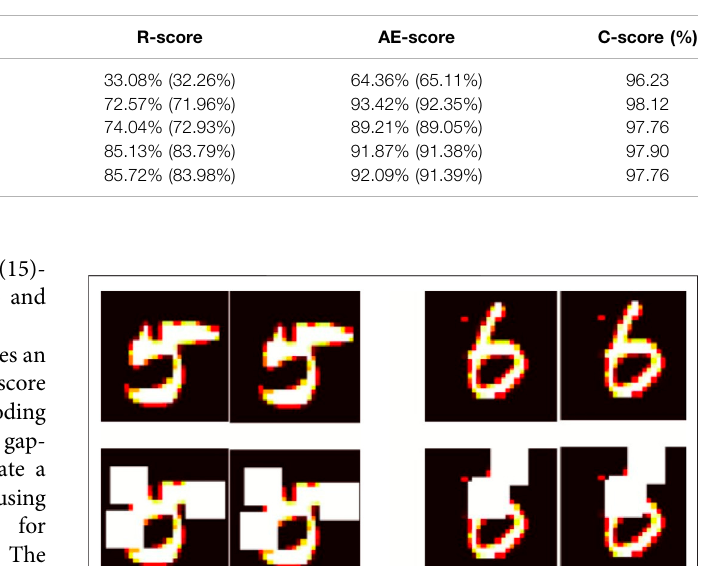
TABLE 1 | Performance of AE schemes in the presence of missing data for the MNIST dataset: for a given convolutional AE architecture (see main text for details), the EOF and ConvAE models trained on gap-free data with a 15-iteration projection-based interpolation (resp., DINEOF and DINConvAE); a zero- fi lling strategy with the same ConvAE architecture, which can be regarded as an instance of the proposed scheme with a fi xed-point solver using only one iteration (FP(1)-ConvAE); and the fi xed-point and gradient-based versions of the proposed scheme. For each experiment, we evaluate four measures: the mean of the reconstruction performance for the known image areas(R-score),theinterpolationperformanceforthemissingdataareas(I-score),thereconstructionperformanceofthetrainedAEwhenappliedtogap-freeimages(AE score),andtheclassi fi cationscoreofamultilayerperceptron(MLP)classi fi ertrainedinthetrainedlatentspace fortrainingimagesinvolvingmissingdata.Themetrics are evaluated for both the training dataset ( fi rst row of each model) and the test dataset (second row; numbers in parentheses). We report here the results for missing patterns with 3 9 × 9 missing data areas ( N S (cid:1) 3 and W (cid:1) 9). R-score, I-score, and AE-score values are given as percentage of explained variance. The results for the other missing data patterns are reported in Supplementary Table S1 .